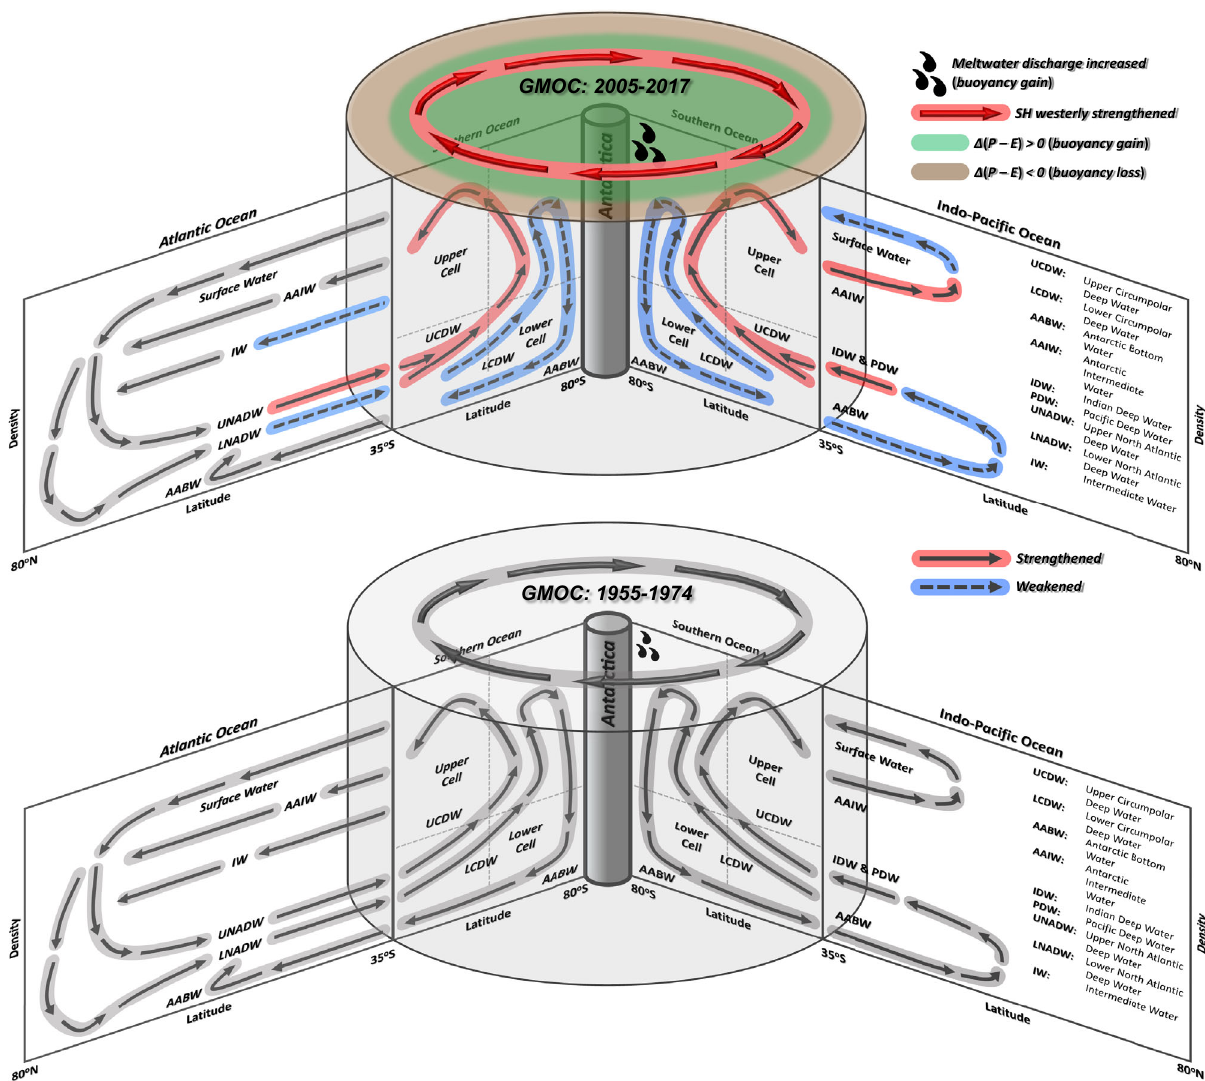
Fig. 6 Major changes in the GMOC and the drivers. A summary schematic of the GMOC in (upper panel) 2005 – 2017 and (lower panel) 1955 – 1974. Major changes in the GMOC and the associated increases in SH westerly and Antarctic meltwater discharge and P − E changes in 2005 − 2017 in reference to 1955 – 1974 are also indicated in the upper